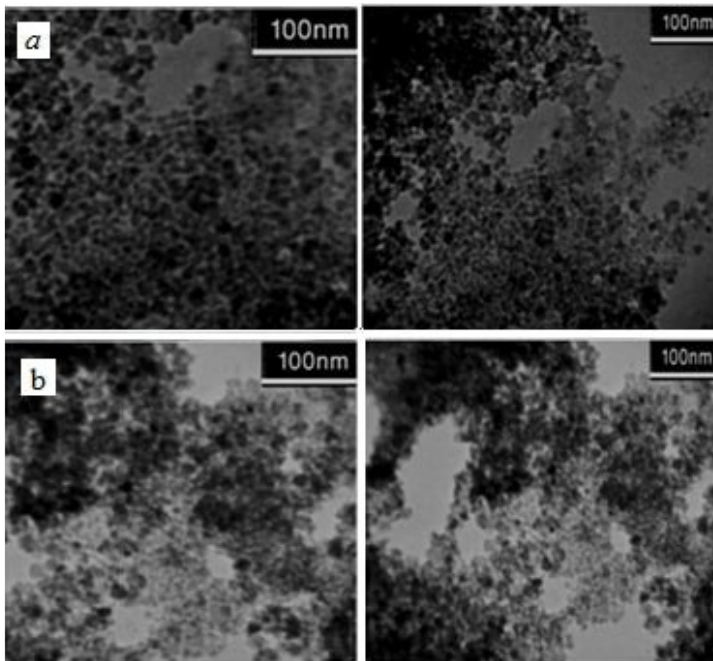
O -SiO @Gold nanoparticles and (b) Fe 3 4 2